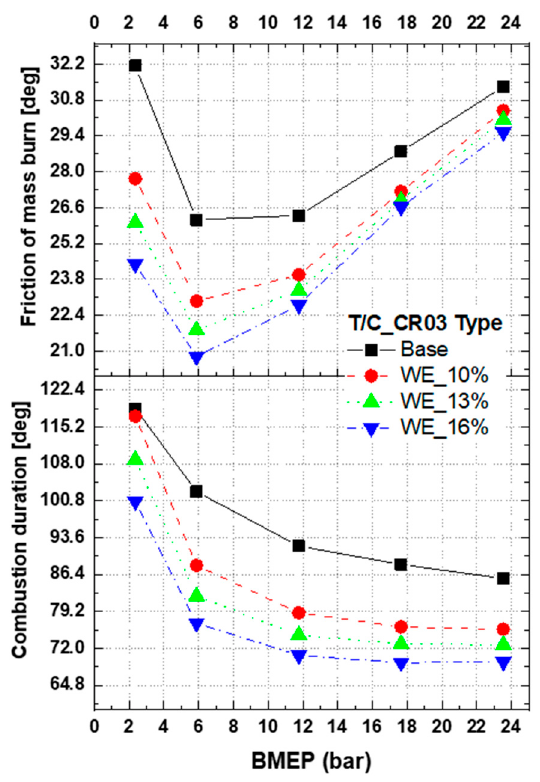
Figure 12. Characteristics of the friction at 90% mass burning and the combustion duration versus three types of emulsified MDOs versus the CR03 type turbocharger compression ratio (meaning of WE_10% is water emulsion including 10% water concentration).